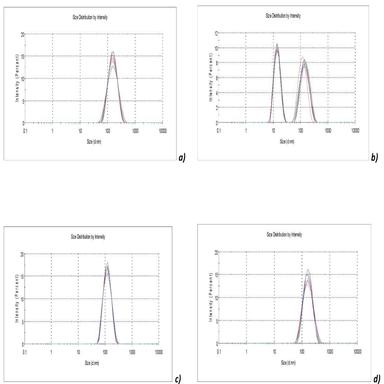
DLS size distribution profiles of PPPs: a) CS; b) EC; c) OD; d) WP.